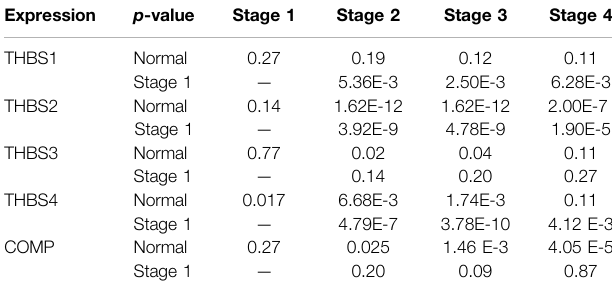
TABLE 1 | The UALCAN results of the differential THBSs expression levels between the gastric cancer and normal tissues and correlation with tumor